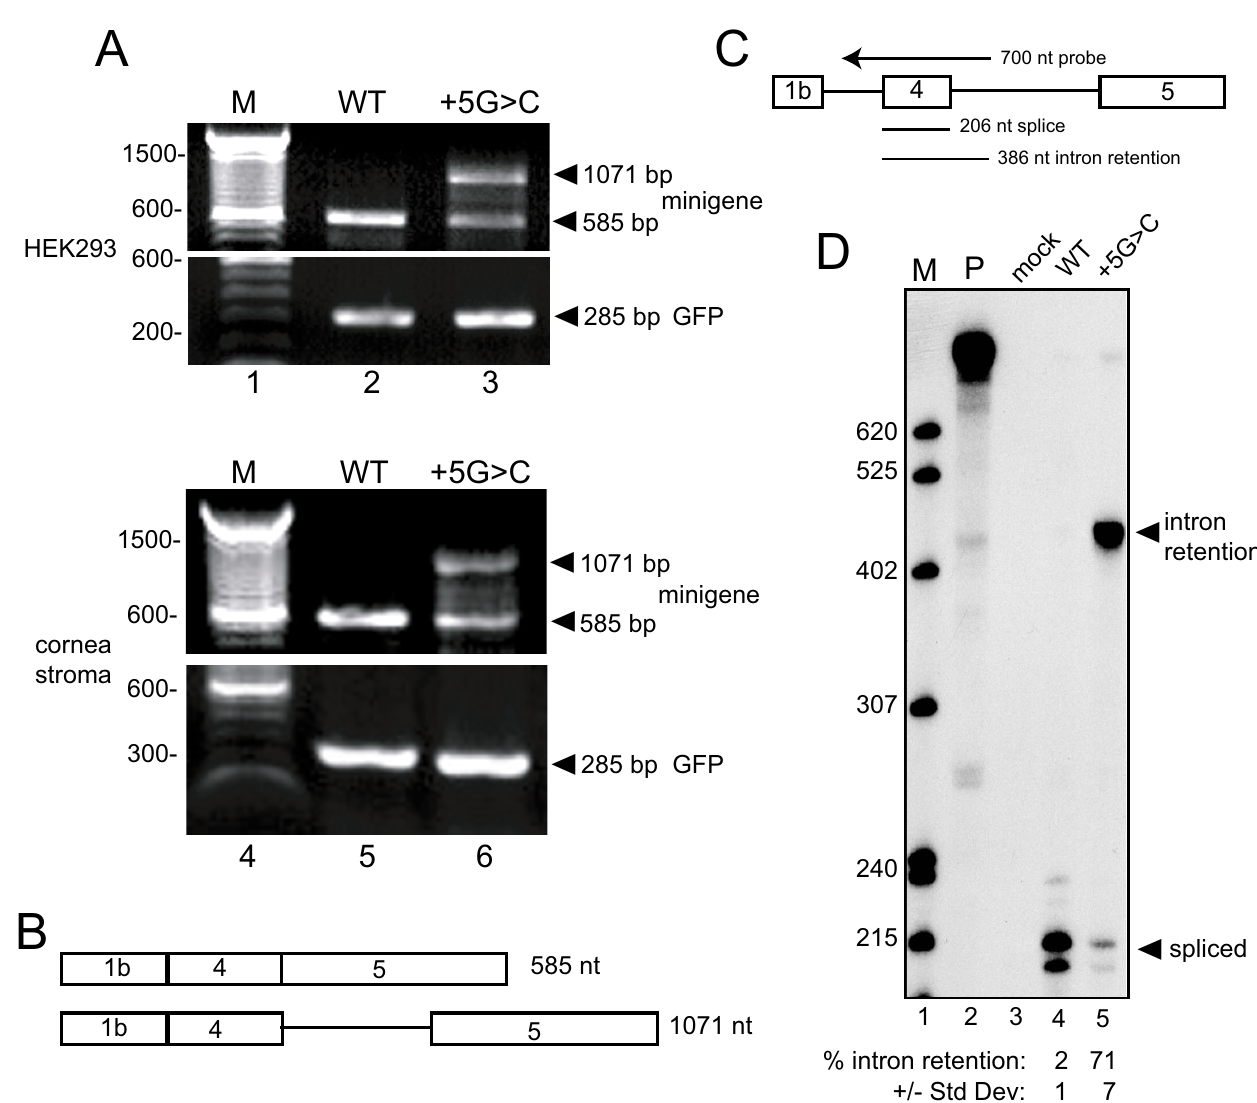
Figure 5 The IVS4+5G>C mutation causes intron retention . A. RNA from HEK293 cells (lanes 2 and 3) or human cornea stro- mal cells (lanes 5 and 6) transfected with WT or IVS4+5G>C minigenes and GFP was subjected to RT-PCR and products were resolved on an agarose gel. The positions of correctly spliced (585 bp), intron retention (1071 bp), and GFP products are shown at the right. M, 100 bp size standards with selected sizes shown. B. Diagram depicting the RNA structure of RT-PCR products from (A) that were cloned and sequenced. At the top is correctly spliced RNA, the bottom is RNA that retains the intron downstream of exon 4. C. Schematic of the RNase protection probe and protected products observed in D. The sizes of the probe and protected products are indicated. D. RNase protection assay (RPA). HEK293 RNA was subjected to RPA, protected products were resolved on a 6%–8 M urea polyacrylamide gel, and a phosphorimage is presented. Correct splicing generates a ~206 nt band and intron retention gives a ~386 nt band. M, 32 P-labeled pBR322/MspI markers with sizes indicate on the left; P, undigested probe; mock, RPA using RNA from untransfected cells; WT, RNA from WT minigene-transfected cells; +5G>C, RNA from mutant IVS4+5G>C minigene-transfected cells. The positions of correctly spliced and intron reten- tion protected products are shown at the right. The doublet bands for spliced product are likely due to incomplete RNase digestion. Below the lanes is quantitation of % intron retention (+/- standard deviation) as assessed by PhosphorImager analysis (n =